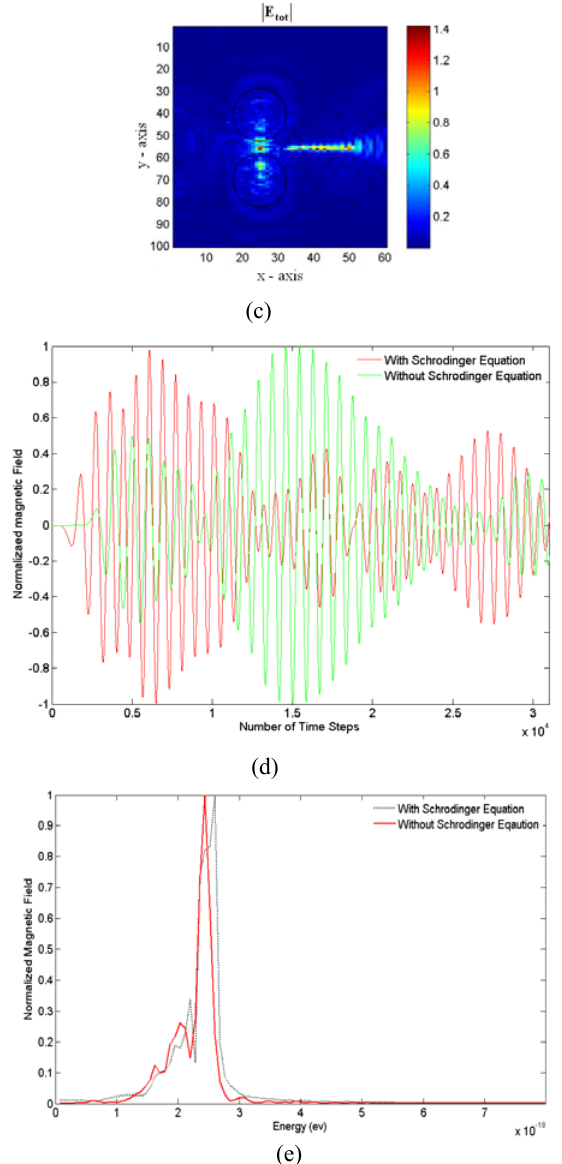
Fig. 2: (a) Structure for example 1, (b) Field intensity in the xy plane without nanowire (c) Field intensity in the xy plane with nanowire (d) Normalized magnetic field intensity with and without Schrödinger equation (e) Normalized field with respect to energy (eV). Figure 3(b) show s the n ormalized electric fie ld i ntensity near the center of the NW, under two different situations, i) the field is e xcited a nd localized betw een nan ospheres at one-end of the NW (from example 1, green color line), ii) the field is ex cited and loca lized a t both-ends o f the NW (example 2, red c olor line). It r epresents that in t he case of resonance field at one end (e xample 1), the field becomes weaker w ith the pa ssage of time, w hile in the c ase of resonance fie ld a t both ends of the N W ( example 2), amplitude of field remains stronger for longer time along